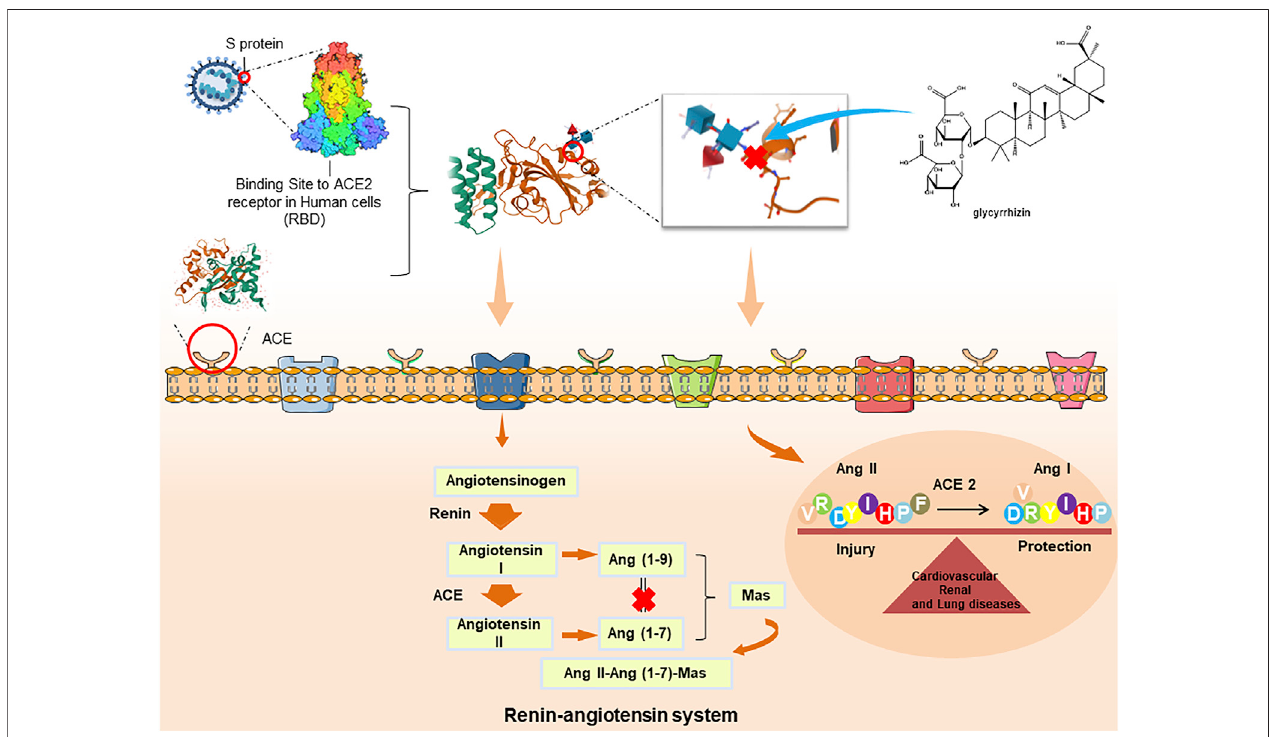
FIGURE 4 | Interaction between SARS-CoV2 and ACE2 under the action of licorice.